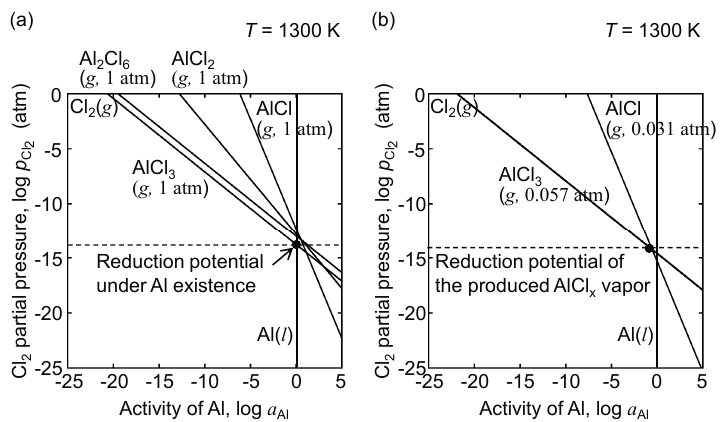
Figure 8. Chemical potential diagram of the Al-Cl system at 1300 K [28] for (a) 1 atm gases and (b) the produced AlCl x vapor.